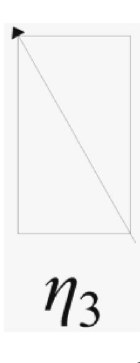
Figure 2. NonlinearNewtonian dashpot.